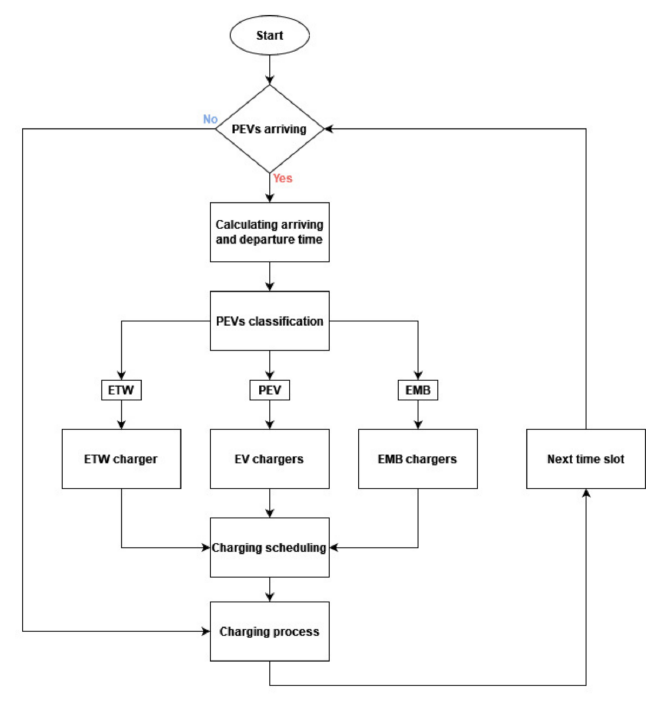
Figure 6. Flow chart for uncoordinated